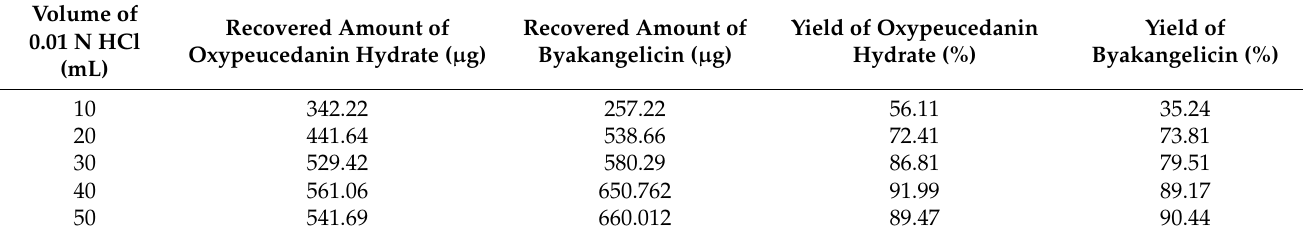
Table 6. Recovery of oxypeucedanin hydrate and byakangelicin using distinct volumes of 0.01 N HCl. Volume of 0.01 N HCl